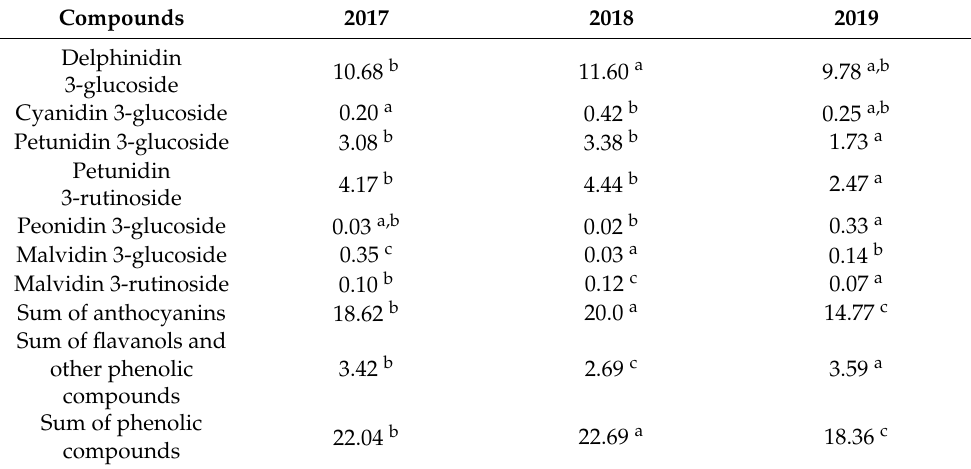
Table 3. Main anthocyanins, flavanols and other phenolic compounds detected by high performance liquid chromatography (HPLC) and found in the Calafate berry over three consecutive years.